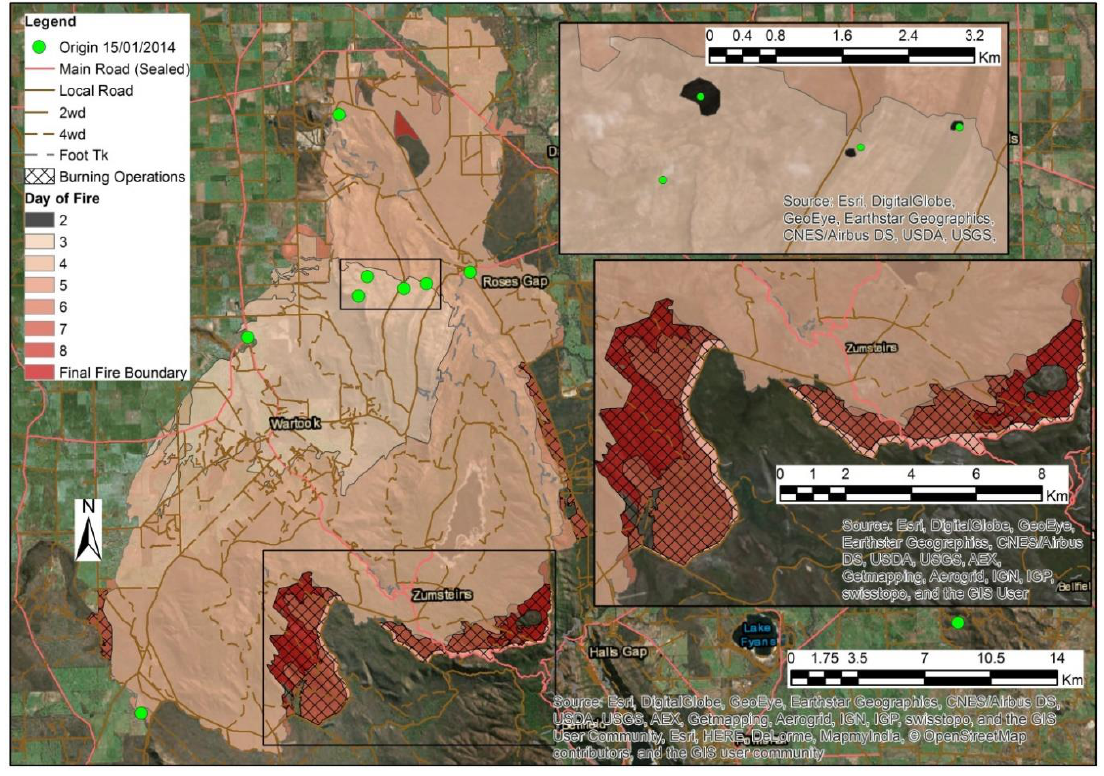
Figure A10. Grampians fire progression map.